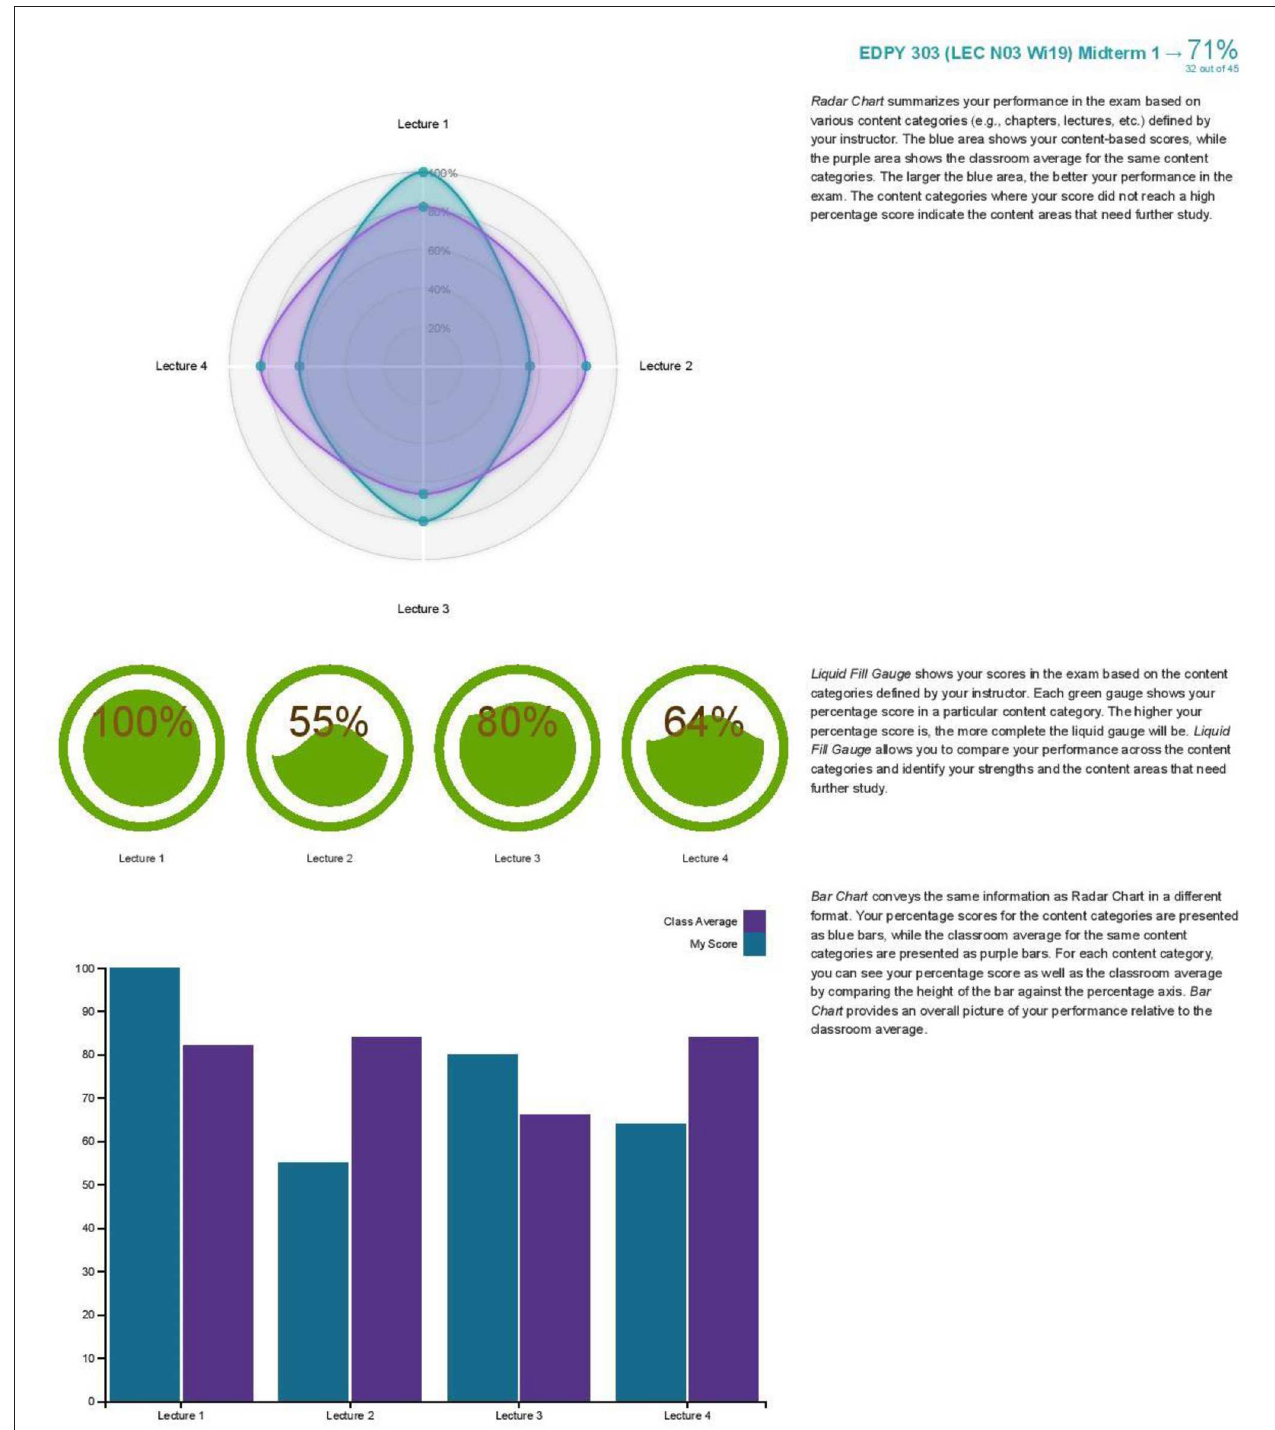
FIGURE 3 | Examples of data visualizations generated for the extended version of the ExamVis score